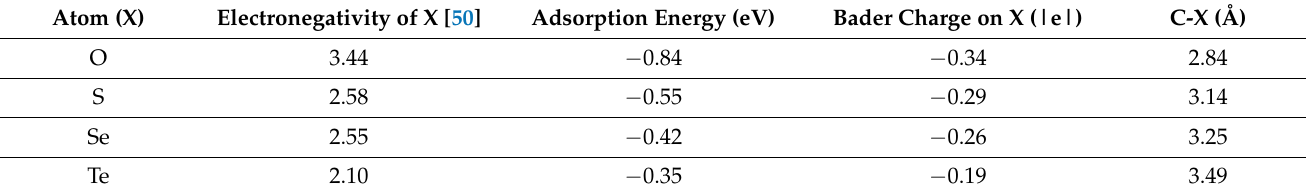
Table 3. Calculated adsorption energies, Bader charges on the dopant atoms and C-X bond distances in the most stable